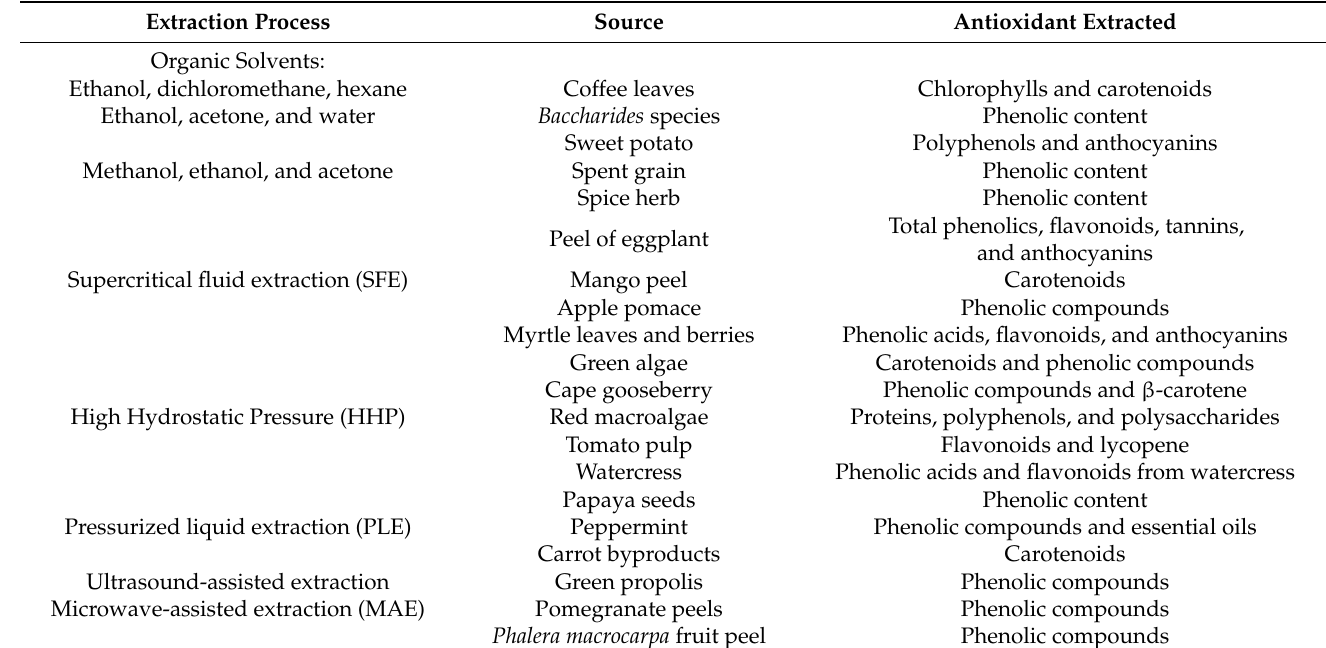
Table 2. Extraction techniques for different classes of naturally occurring antioxidants